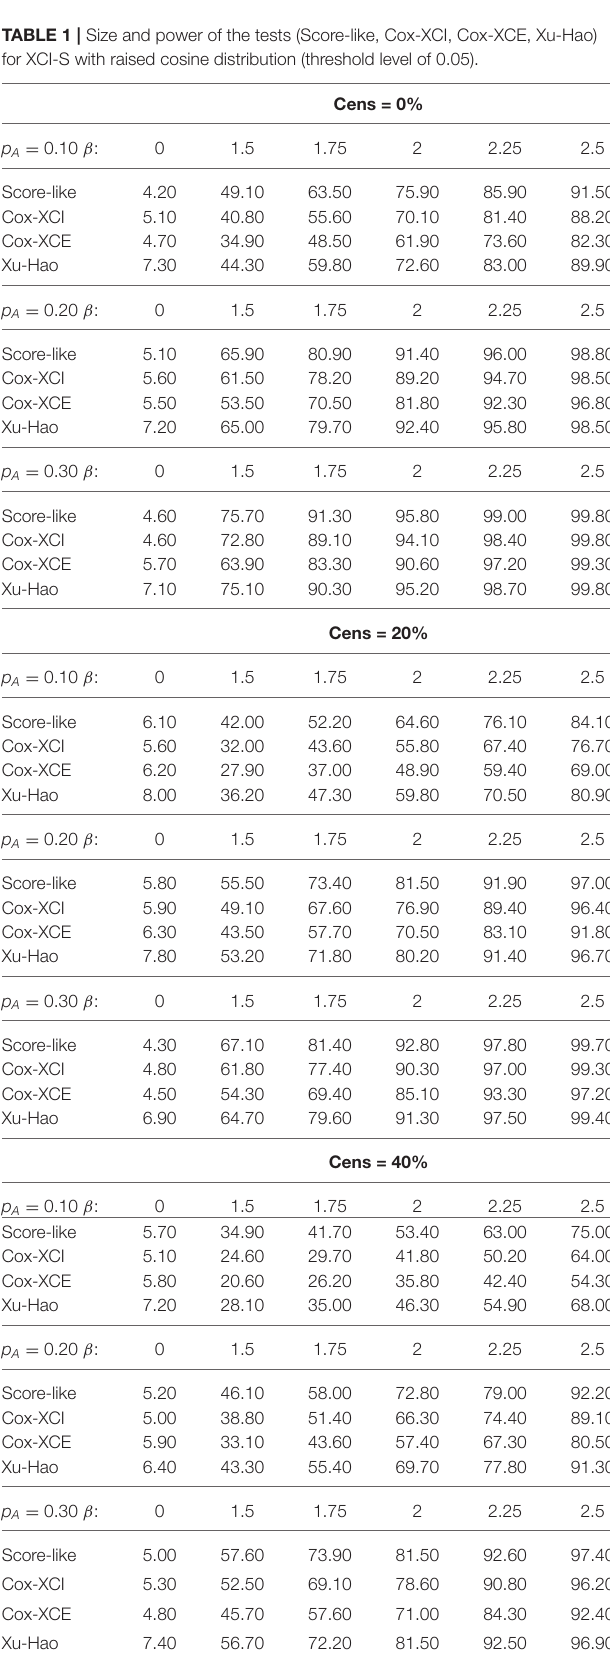
TABLE 1 | Size and power of the tests (Score-like, Cox-XCI, Cox-XCE, Xu-Hao) for XCI-S with raised cosine distribution (threshold level of